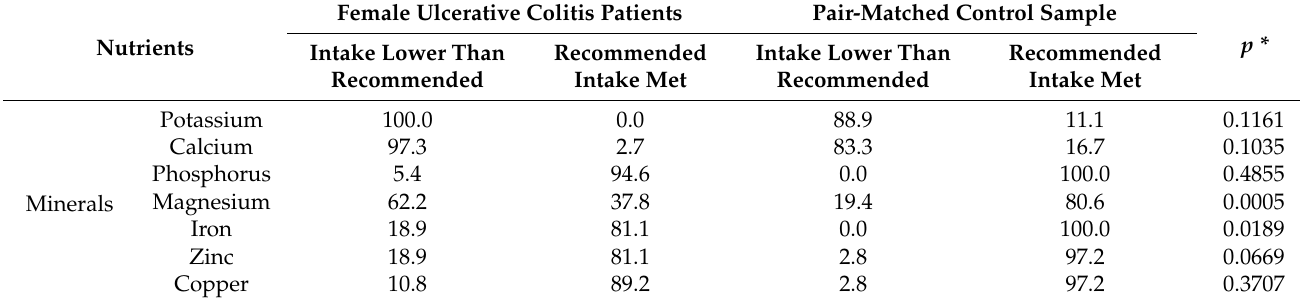
Table 10. The proportion of individuals meeting the recommended intake for minerals and vitamins for the age-dependent reference intake values for estimated average requirement (EAR)/adequate intake (AI) values in the studied Polish female ulcerative colitis individuals, in comparison with a pair-matched control